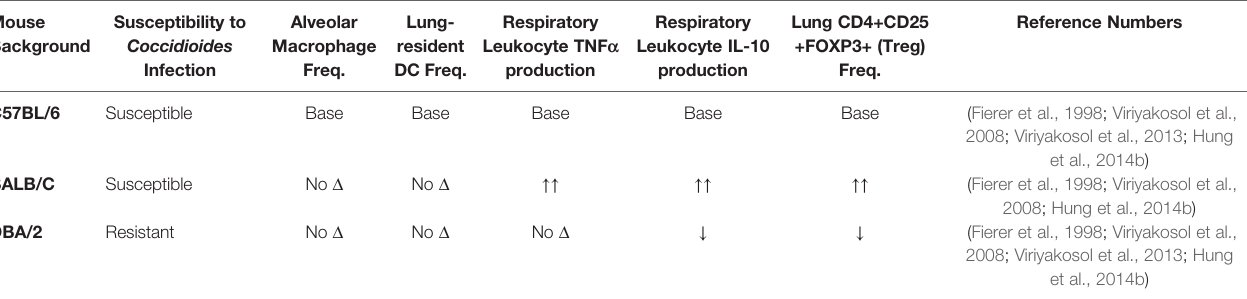
Susceptibility to